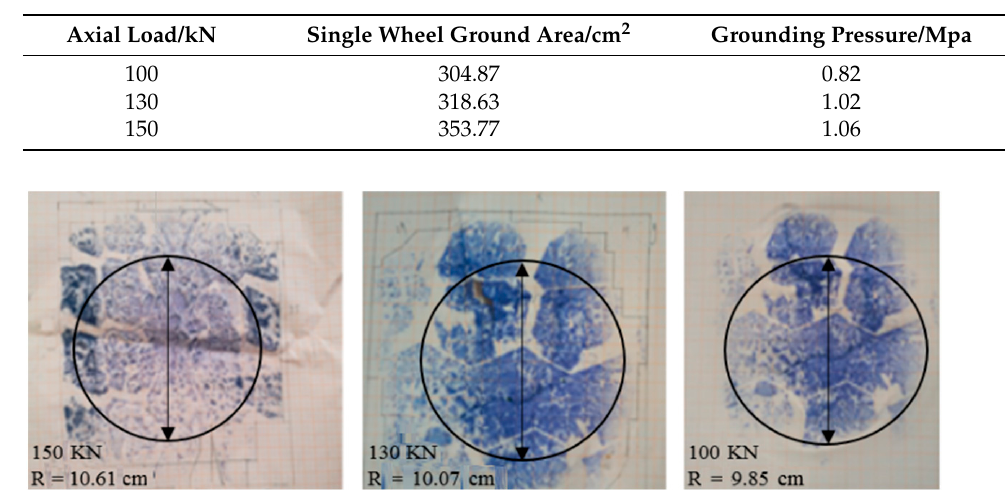
Table 4. Wheel ground area under different ground areas.